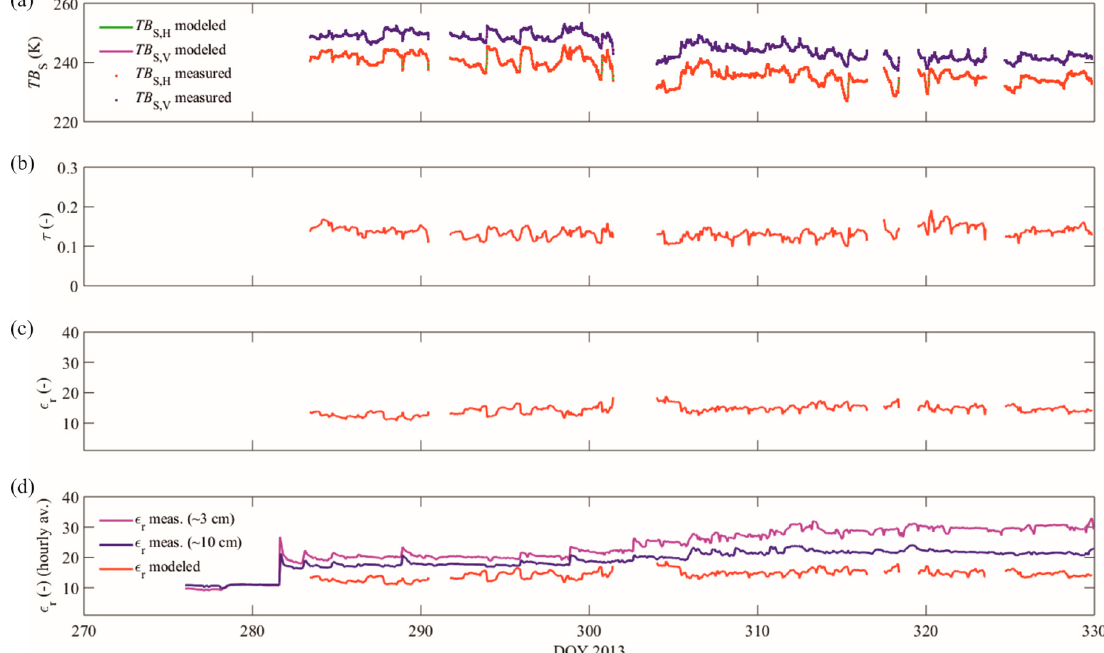
Figure 8. ( a ) Measured (blue and red dots) and modelled (green and magenta lines) L-band brightness temperatures ( TB S ) at horizontal and vertical polarizations. Modelled TB S, p data were obtained using the τ - ω radiative transfer model. It should be noted that the modelled data can hardly be seen on the plot because of the perfect agreement between the measured and modelled data. ( b ) Vegetation optical depth ( τ ); and ( c ) soil relative dielectric permittivity ( ε r ) derived from TB S, p data. ( d ) Comparison of hourly mean radiometer-derived ε r with in situ ε r measurements at 3 and 10 cm depth.